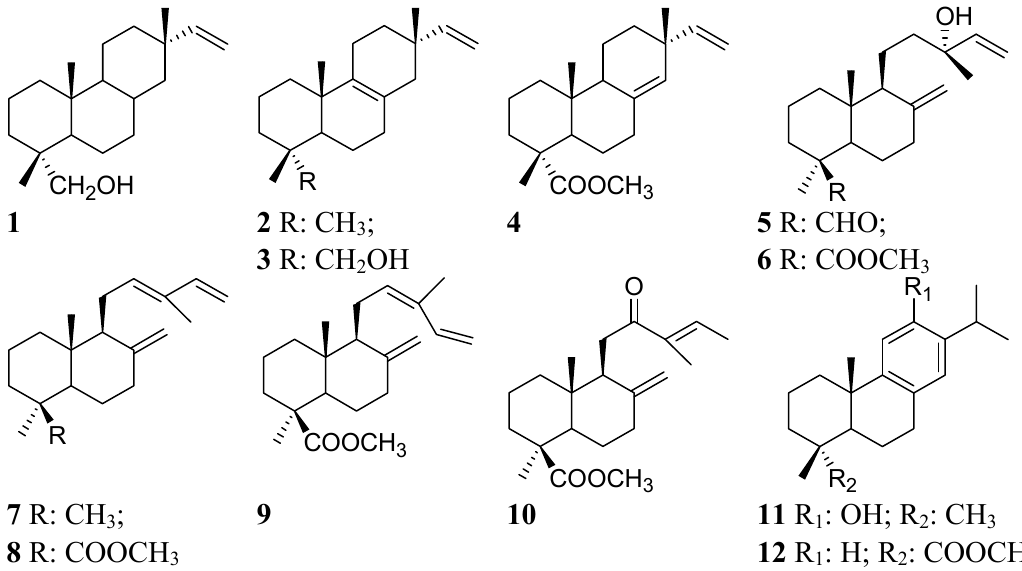
Figure 1. Structure of the main compounds from the resin of Austrocedrus chilensis used for the PCA analysis. Compounds: 18-hydroxyisopimar-15-ene ( 1 ); isopimara-8(9),15-diene ( 2 ); 18-hydroxyisopimara-8,15 diene ( 3 ); sandaracopimaric acid methyl ester ( 4 ); torulosal ( 5 ); torulosic acid methyl ester ( 6 ); 8(17),12,14-labdatriene ( 7 ); E -communic acid acid methyl ester ( 8 ); Z -communic acid methyl ester ( 9 ); 12-oxo-labda-8(17),13 E -dien-19-oic acid methyl